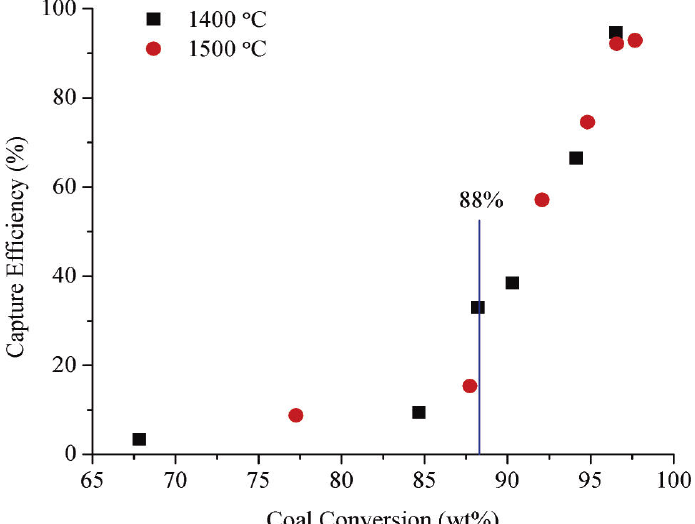
Figure 7. Particle collection efficiency as a function of coal conversion